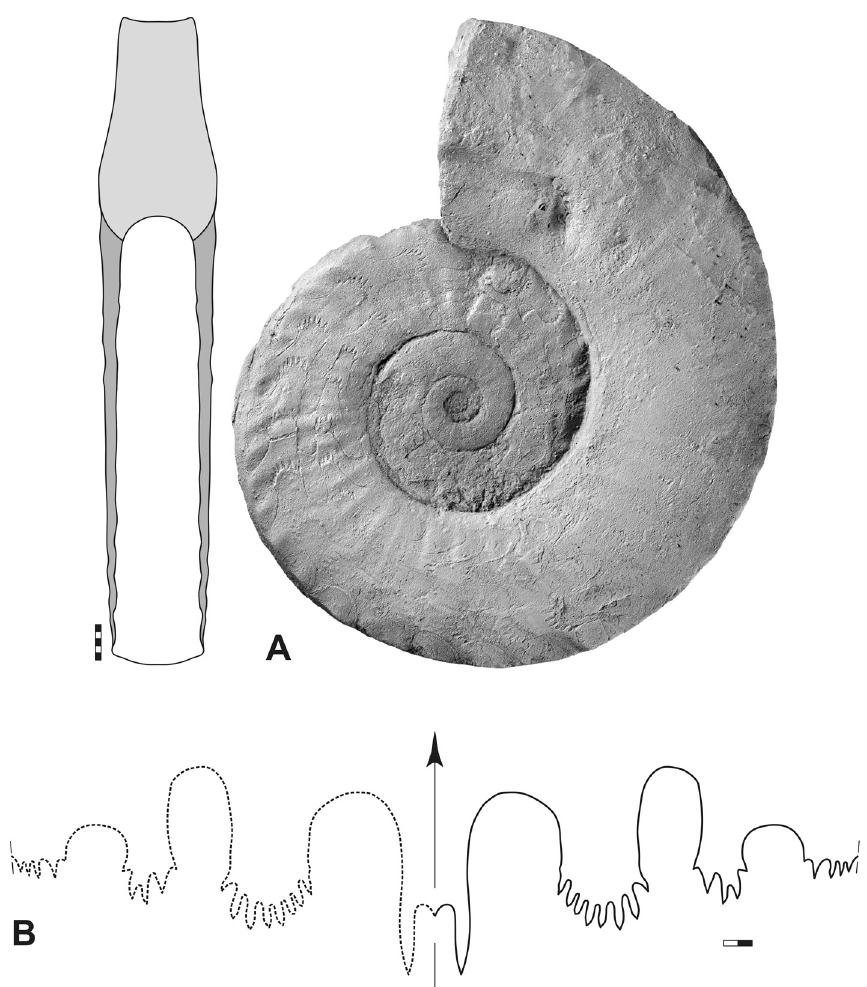
Fig. 54. Lutites alius Korn & Hairapetian gen. et sp. nov. A . Lateral and dorsal view, holotype specimen MB.C.30013, section E, float. B . Suture line, specimen MB.C.30013, at 64.3 mm dm, 13.5 mm ww, 22.6 mm wh. Abbreviations: see Material and methods. Scale bar units = 1